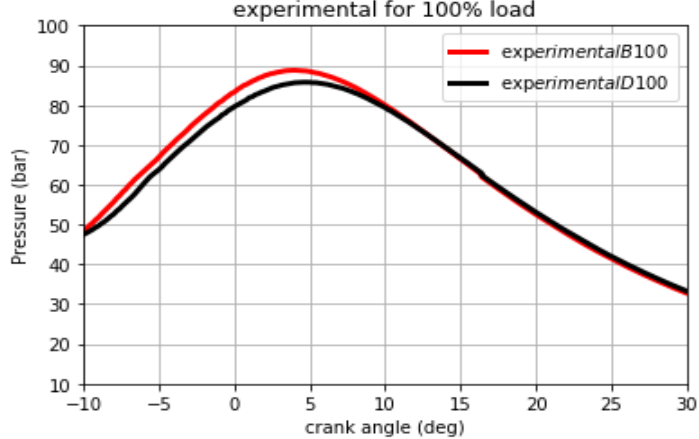
Figure 3. Comparison of experimental pressures of B100 and D100 at 100% load.